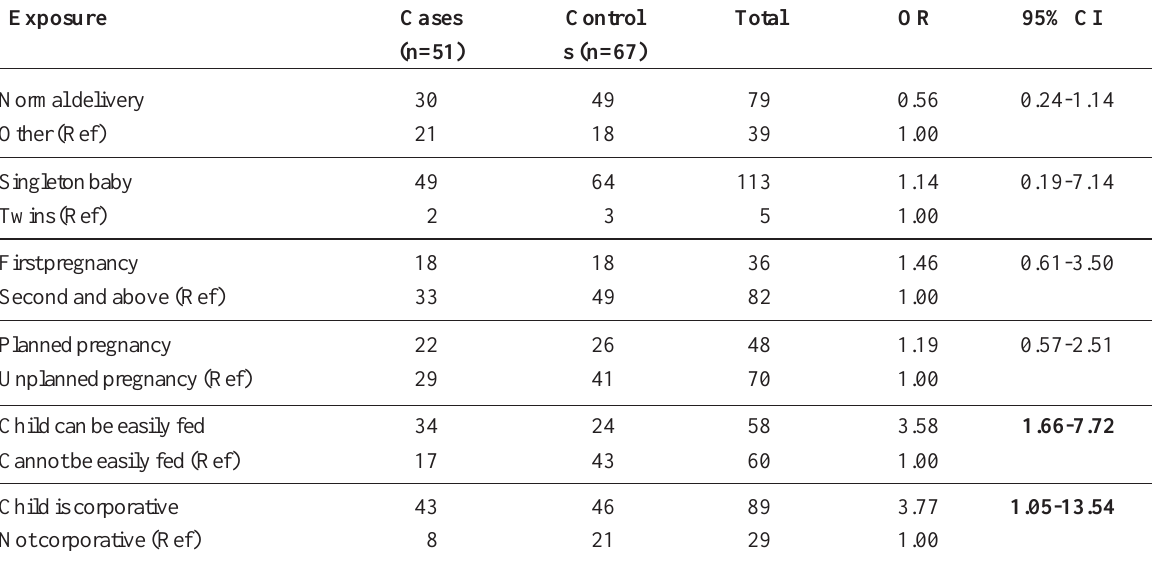
Table 3. Association of different exposures to the status of growth in cases and